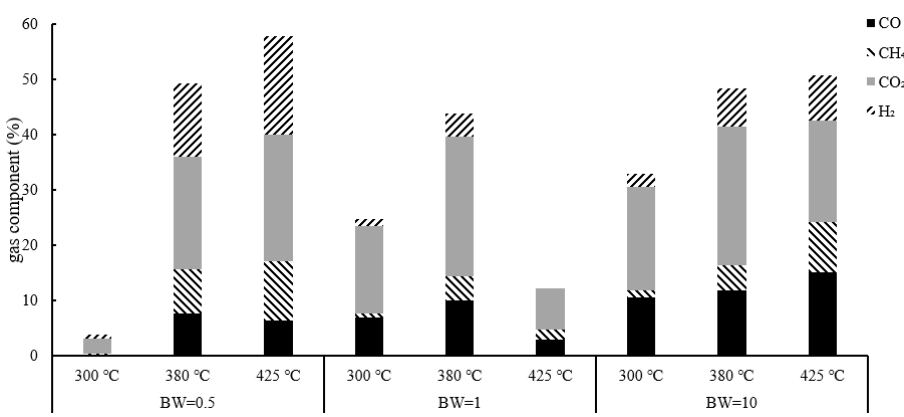
Figure 6. Gas component analysis result of group 1.